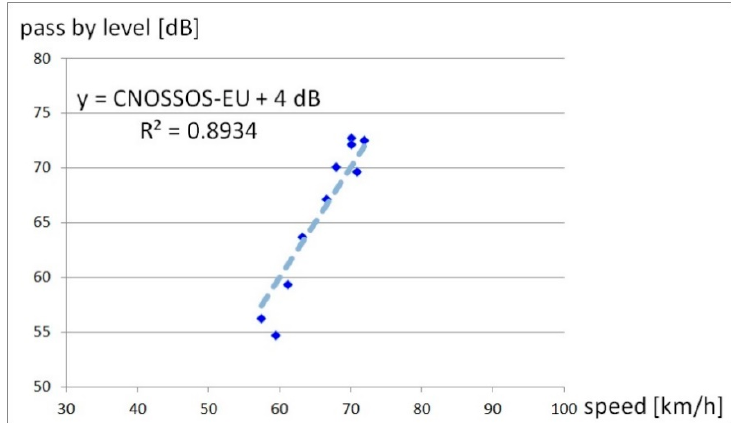
Figure 2. Adjusting the motorcycle emission model; mean values of adjusted measurements and linear regression line for adaption of motorcycle emission values by +4 dB.